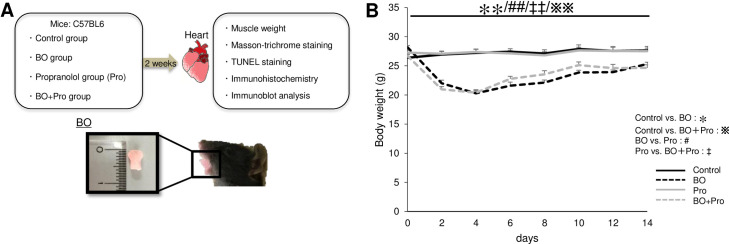
Experimental procedure and daily body weight.(A) Male 12-week-old C57BL/6 mice were divided into four groups: a normal control group (Control), a bite-opening (BO)-treated group, a (±)-propranolol hydrochloride (Pro)-treated group, and a BO plus Pro-treated group (BO + Pro). Propranolol was directly dissolved in drinking water (80 mg/kg/day; freshly prepared every day) for 2 weeks. (B) Body weight was measured daily for all animals throughout the 2-week experimental period. **P < 0.01 (Control (n = 6) vs. BO (n = 8)), ※※P < 0.01 (Control vs. BO + Pro (n = 10)), ##P < 0.01 (BO vs. Pro (n = 6)), ‡‡P < 0.01 (Pro vs. BO + Pro) by two-way repeated-measures ANOVA followed by the Bonferroni post hoc test (S1 Fig of S1 Data).